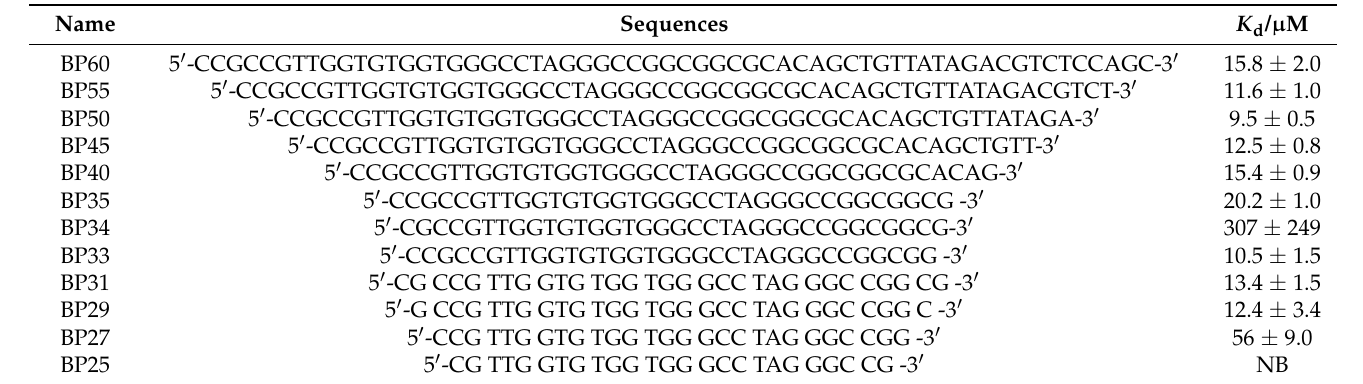
Figure 2. The secondary structures of BP60, BP35 (BP35-1 and BP35-2), BP-34, and BP-33. Table 1. Summary of sequences and binding affinity of truncated aptamers from BP60.